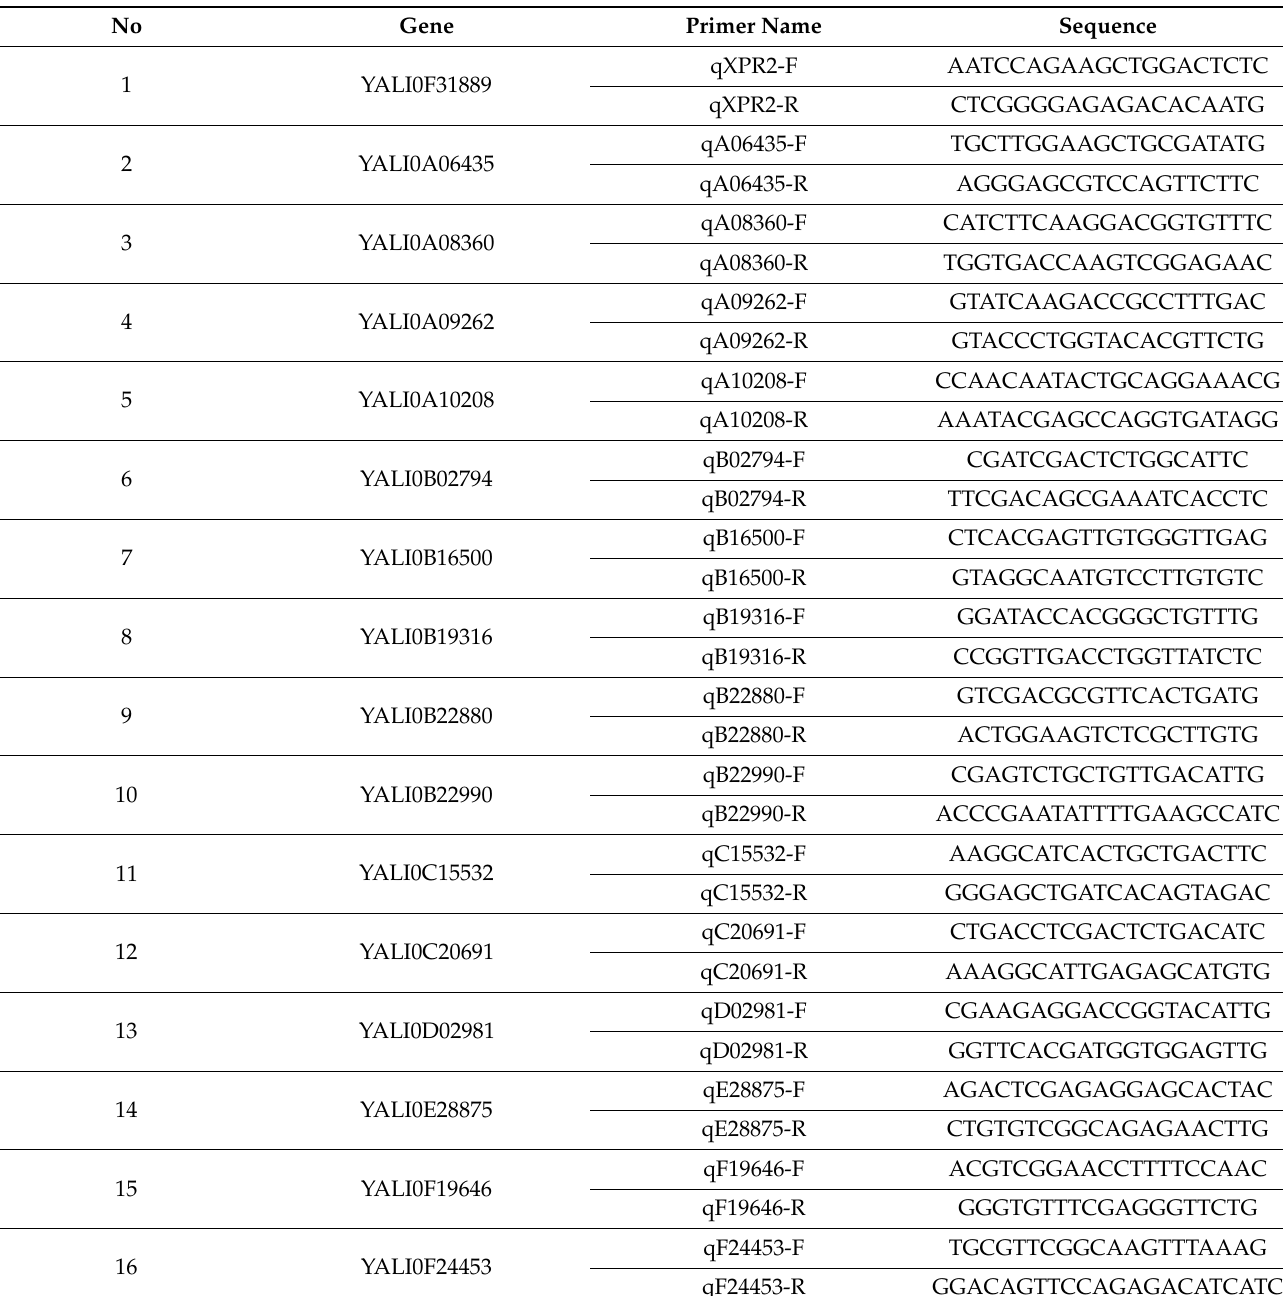
Table 5. Primers used for alkaline proteases expression